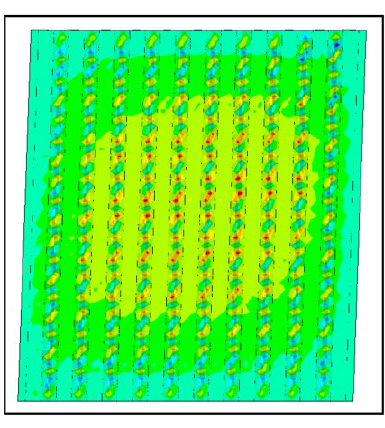
Figure 14. Global